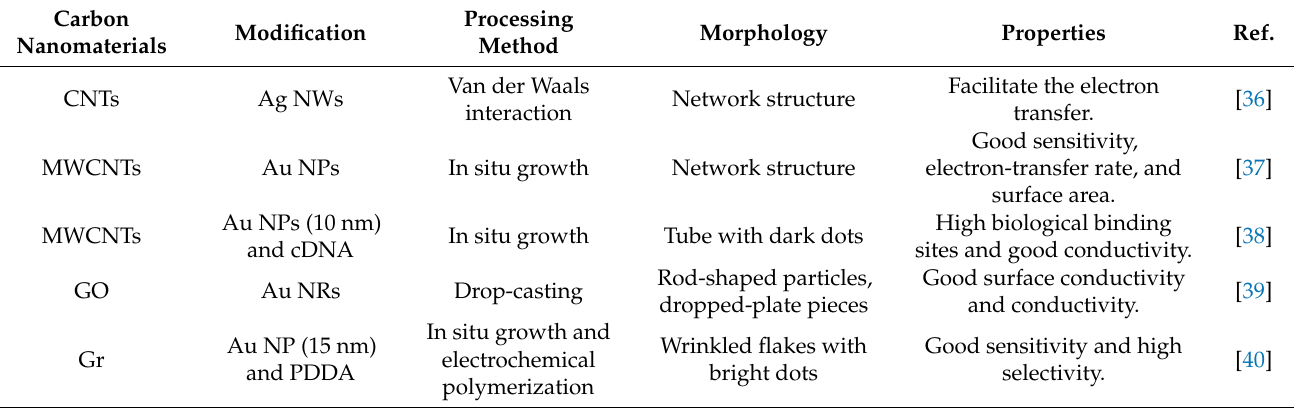
Table 1. Different molecules are used to modify CNMs, their processing methods, and their